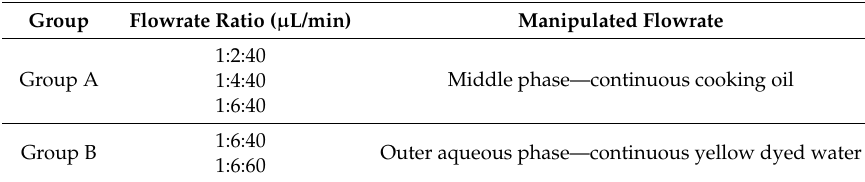
Table 3. Summary of the flowrate ratio and the manipulated parameter.